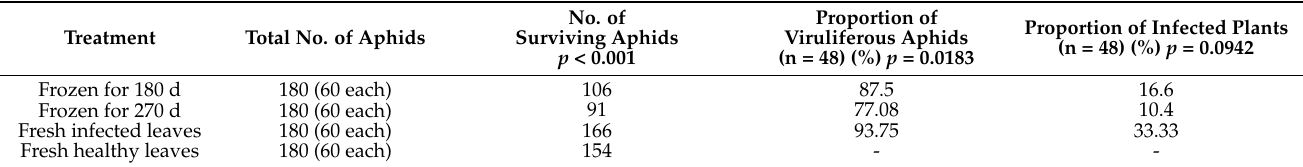
Table 2. Percentages of viruliferous aphids and BrYV-infected plants as a result of aphids feeding on frozen or fresh infected leaves; each experiment was performed three times independently 1 .